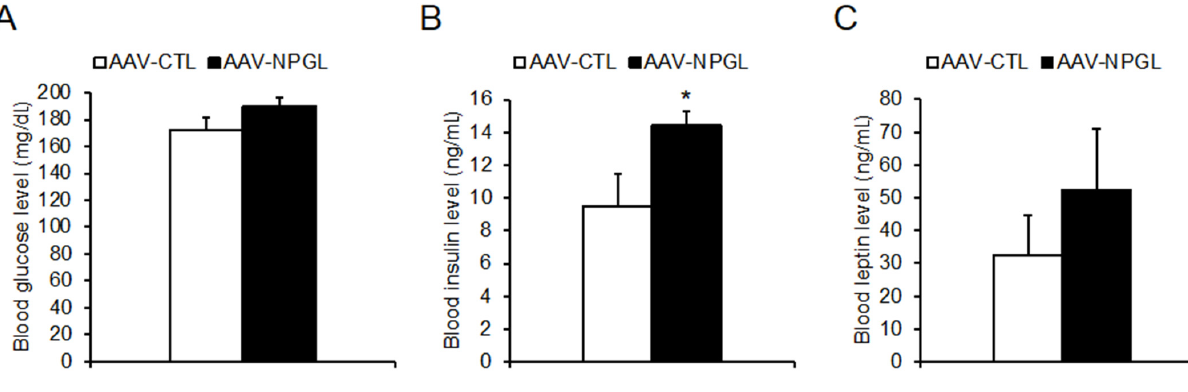
Figure 5. Effects of Npgl overexpression on blood biomarkers in mice fed a high-fat diet with 60% calories from fat. These mice were 26 weeks old at 18 weeks after injection of an adeno-associated virus (AAV) vector, either a control (AAV-CTL) or a vector carrying the NPGL precursor gene (AAV-NPGL). ( A – E ) Levels of blood glucose ( A ), insulin ( B ), leptin ( C ), triglycerides (TG) ( D ), and free fatty acids (FFA) ( E ). All statistical analyses were performed using Student’s t -test. Each value represents the mean ± standard error of the mean (AAV-CTL: n = 8, AAV-NPGL: n = 8; * p < 0.05). 2.4. mRNA Expression of Neuropeptide Genes and Genes Regulating Lipid Metabolism To illuminate the potential causes of our observations regarding increased food in- take and changes in the mass of adipose and non-adipose tissues, we measured the mRNA expression levels of feeding-related neuropeptides in the MBH, along with the mRNA expression of genes regulating lipid metabolism in the inguinal WAT (iWAT), eWAT, and liver. The following genes were analyzed: Npy and Agrp , encoding orexigenic factors as previously described; Pomc , encoding an anorexigenic factor as previously described; Acc (acetyl-CoA carboxylase), Fas (fatty acid synthase), Scd1 (stearoyl-CoA desaturase), and Gpat1 (glycerol-3-phosphate acyltransferase 1), encoding lipogenic enzymes; Chrebp α (car- bohydrate-responsive element-binding protein α ), encoding a lipogenic transcription fac- tor; Cpt1a (carnitine palmitoyltransferase 1a), Atgl (adipose triglyceride lipase), and Hsl (hormone-sensitive lipase), encoding lipolytic enzymes; Gapdh (glyceraldehyde-3-phos- phate dehydrogenase), encoding an enzyme involved in carbohydrate metabolism; Slc2a4 and Slc2a2 (solute carrier family 2 members 4 and 2), encoding glucose transporters; Cd36 (cluster of differentiation 36), encoding a fatty acid transporter; Ppar α and Ppar γ (peroxi- some proliferator-activated receptor α and γ ), encoding lipid-activated transcription fac- tors; G6pase (glucose-6-phosphatase) and Pepck (phosphoenolpyruvate carboxykinase),